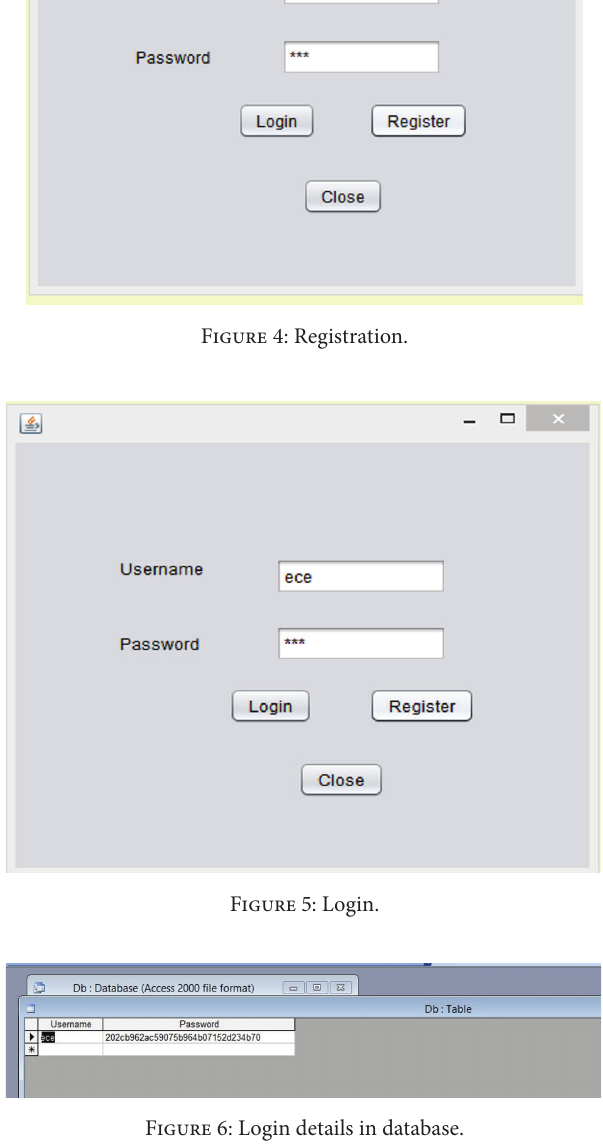
Figure 6: Login details in